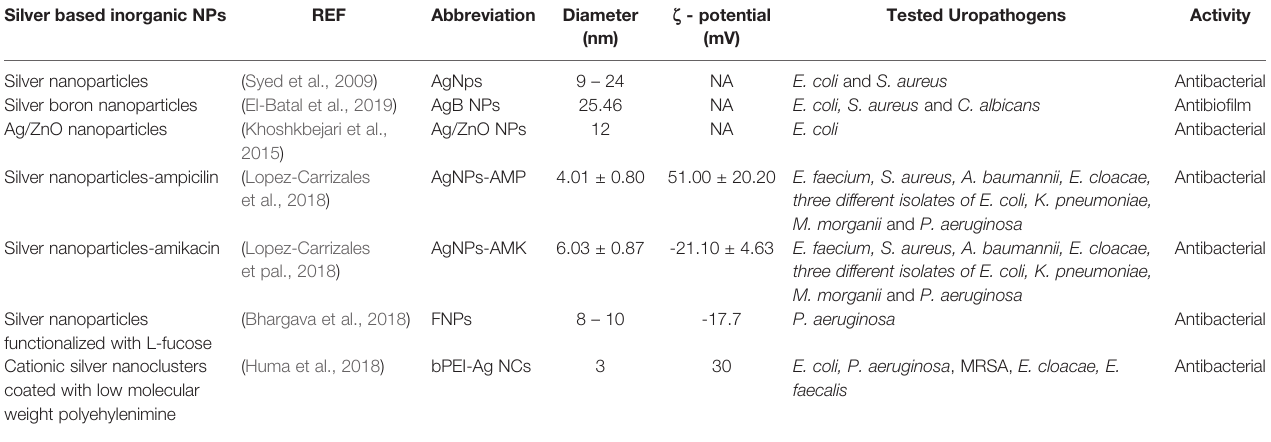
TABLE 3 | Physicochemical characteristic of silver-based